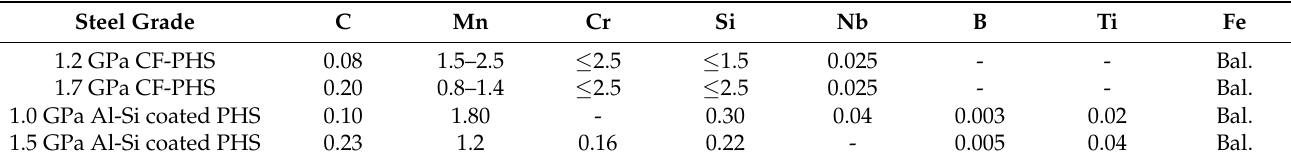
Table 1. Compositions of the designed and reference steels (wt.%).